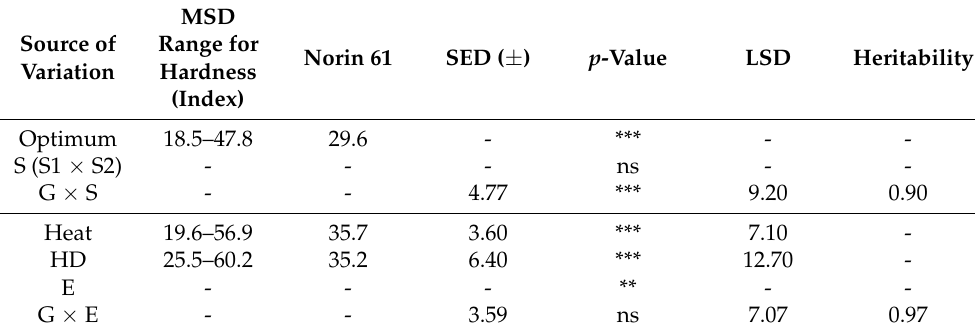
Table 1. Analysis of variance and heritability for hardness under optimum, heat and HD environ- ments for MSD